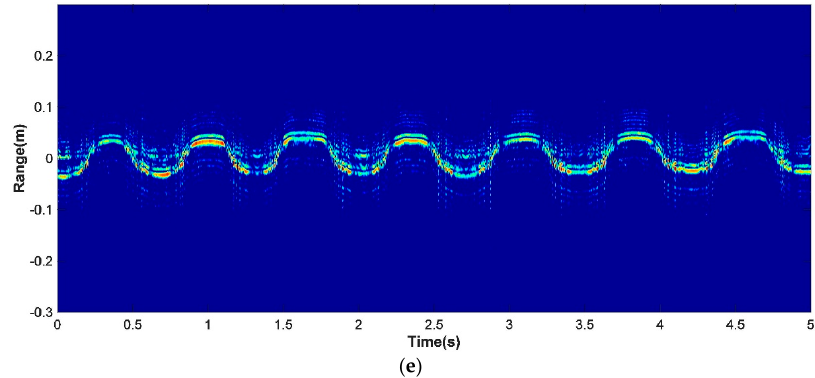
Figure 4. ( a – d ) HRRP of a hand at a certain point in time; ( e ) HRRP sequences of a dynamic gesture over five seconds, where the brightness represents the amplitude ( a – d ).